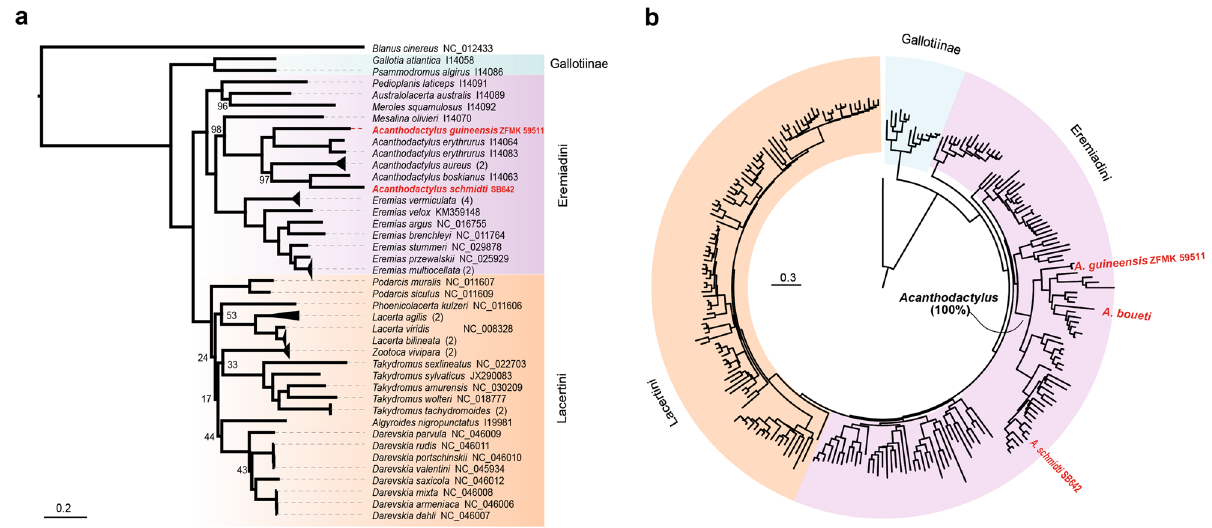
Figure 1. Phylogenetic position of the newly assembled mitogenomes of Acanthodactylus guineensis and A. schmidti . ( a ) Phylogenetic reconstruction based on a novel mitogenomic alignment of DNA sequences from 50 terminals, including 14,241 sites of 12S and 16S rRNAs plus the 13 protein-coding genes. Numbers in parentheses mark species for which more than one mitochondrial genome was available (see Supplementary Fig. S1 online; collapsed a posteriori for graphical representation), focal taxa are highlighted in red. Branch thickness is proportional to ultrafast bootstrap node support values (only values < 100 are shown). ( b ) Phylogenetic reconstruction based on a more comprehensive alignment, with reduced gene coverage, including 3054 sites of the 12S, 16S, COB and ND4 genes from 250 terminals. Focal taxa are highlighted in red. See Supplementary Material online for additional details on the phylogenies and main text for details of the phylogenetic methods used in both and 29 bp in the COB gene for A. guineensis and A. schmidti , respectively, and 149 bp comprising the 3 ′ end of cytochrome c oxidase subunit I gene and the tRNA Serine 2 gene for A. erythrurus. For the mitogenomic phylogeny, two rRNA and 13 protein coding genes were used. Both maximum likelihood and Bayesian analyses recovered monophyletic groups corresponding to the two lacertid subfamilies Gallotiinae and Lacertinae, the two Lacertinae tribes Lacertini and Eremiadini, as well as the two main Eremiadini clades, the Saharo-Eurasian clade (represented here by the genera Mesalina , Acanthodactylus and Eremias ) and the Ethiopian clade (here represented by Meroles , Pedioplanis , Australolacerta ) with high support 6, 7, 9, 32, 33 ; Fig. 1a, Supplementary Figs. S1, S2 online). The only difference between the two trees were the positions of the Lacertini genera Podarcis and Algyroides which switched places (with moderate node support). Within the Eremiadini the majority of nodes received 100% ultrafast bootstrap node support values (posterior probabilities = 1) and no node was supported with less than 96%. The tree further confirms specimen ZFMK 59511 from Burkina Faso to be a member of the genus Acanthodactylus (i.e., A. guineensis based on the morphological identification, see Supplementary Material online) with 100% node support (Fig. 1a, Supplementary Fig. S1 online). Specifically,